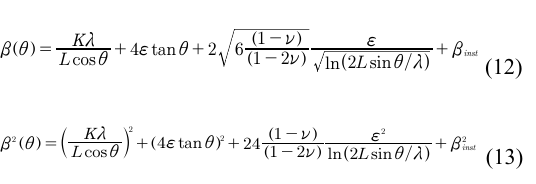
The values of the XRD FWHM , β , determined FWHM from the experimental spectra of all samples, are plotted in Fig. 4. It is observed that β is almost constant at small FWHM diffraction angles, up to a critical value, θ , at which the C line broadening increases nonlinearly. Similar behavior